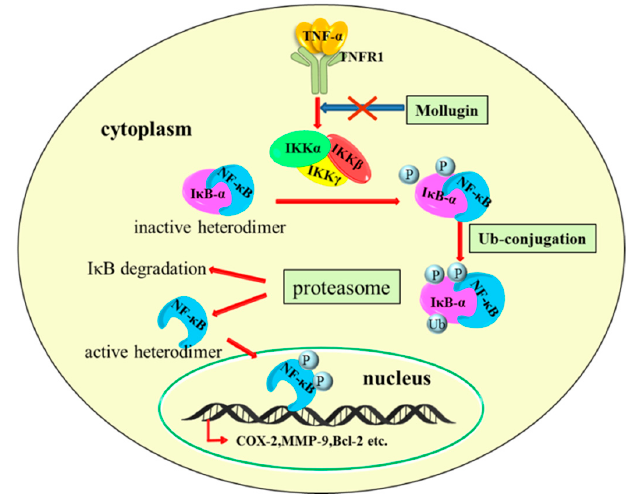
Figure 7. The proposed schematic diagram of signaling pathways for mollugin-mediated, anti-cancer effects. Mollugin blocks TNF- α -induced phosphorylation of the IKK complex as marked by the X symbol in the figure, thereby inhibits the phosphorylation (marked by “P”), ubiquitination (marked by “Ub”), and degradation of I κ B- α . This process inhibits the nuclear translocation of NF- κ B and downstream gene